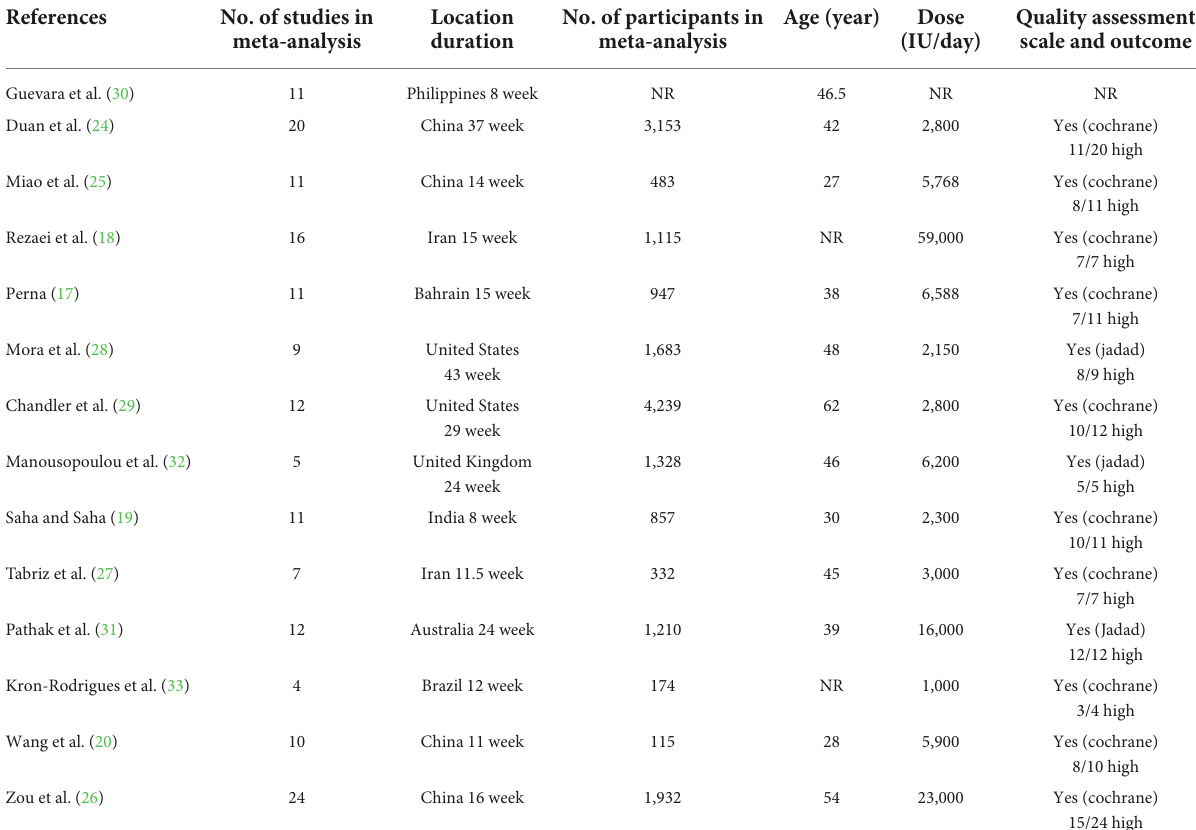
TABLE 1 Study characteristics of included